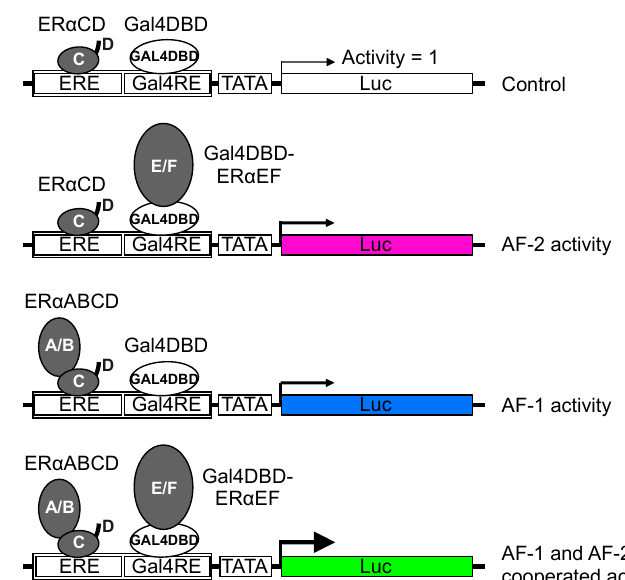
Figure 3. Schematic diagram of a hybrid reporter assay. The activity of reporter gene, which contains a Gal4-binding element (Gal4RE) juxtaposed to an ER binding element (ERE), coexpressed with ER α fragments was analyzed. In experiment, the activities were normalized by the activity of ER α CD and Gal4DBD expressing cells (Control; white). The cells that were coexpressed with ER α CD and Gal4DBD-ER α EF demonstrate AF-2 activity (pink). The cells that were coexpressed with ER α ABCD and Gal4DBD demonstrate AF-1 activity (blue). The cells that were coexpressed with ER α ABCD and Gal4DBD-ER α EF demonstrate AF-1 and AF-2 cooperative activity (green).